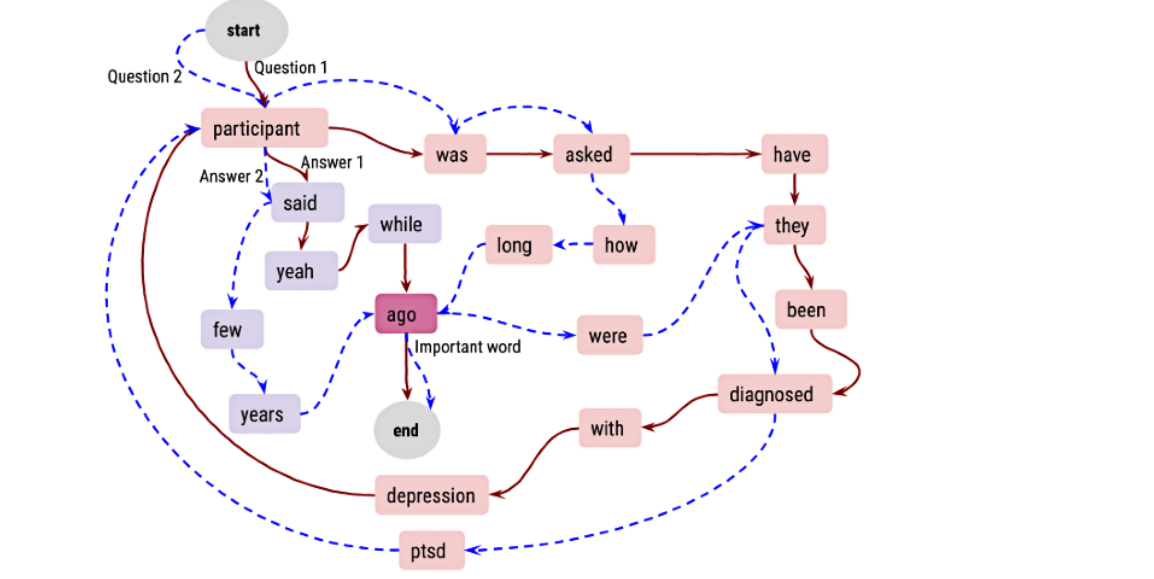
Figure 3. Word Graph (WG) of two Q/A pairs from the Distress Analysis Interview Corpus-Wizard of Oz data set. WG shows “ago” and “diagnosed” as the words with high importance score. WG is created per patient interview and becomes dense as the interview proceeds. This allow the summarizer to locate important words. However, importance scores of domain-specific words “depression” and “ptsd” is elevated using the word semantic score. Start and End are dummy nodes. ptsd: posttraumatic stress